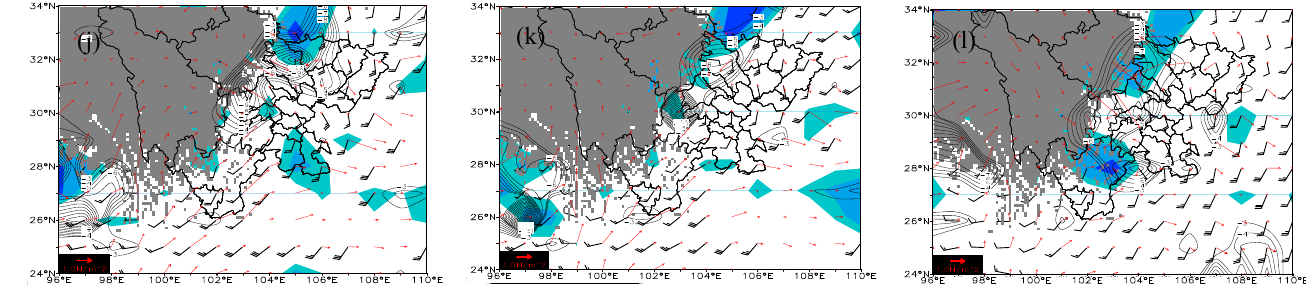
Figure 10. As in Figure 9, but for the gravity wave stress vector (red, N/m 2 ), 700-hPa vertical velocity (contours, 10 − 1 Pa/s), wind field (wind poles, m/s) and negative divergence (color fill, 10 − 5 /s): ( a ) 1200 UTC 7 July; ( b ) 1800 UTC 7 July; ( c ) 0000 UTC 8 July; ( d ) 0600 UTC 8 July; ( e ) 1200 UTC 8 July; ( f ) 1800 UTC 8 July; ( g ) 0000 UTC 9 July; ( h ) 0600 UTC 9 July; ( i ) 1200 UTC 9 July; ( j ) 1800 UTC 9 July; ( k ) 0000 UTC 10 July; ( l ) 1200 UTC 10 July. Grey areas: terrain above 700 hPa.